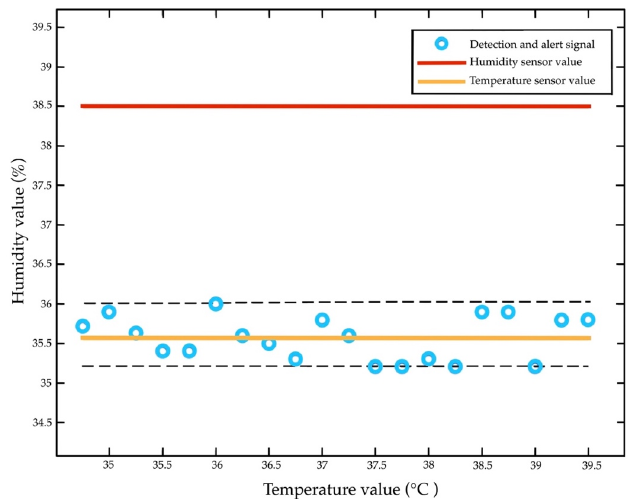
Figure 19. Repeatability of temperature and humidity values.